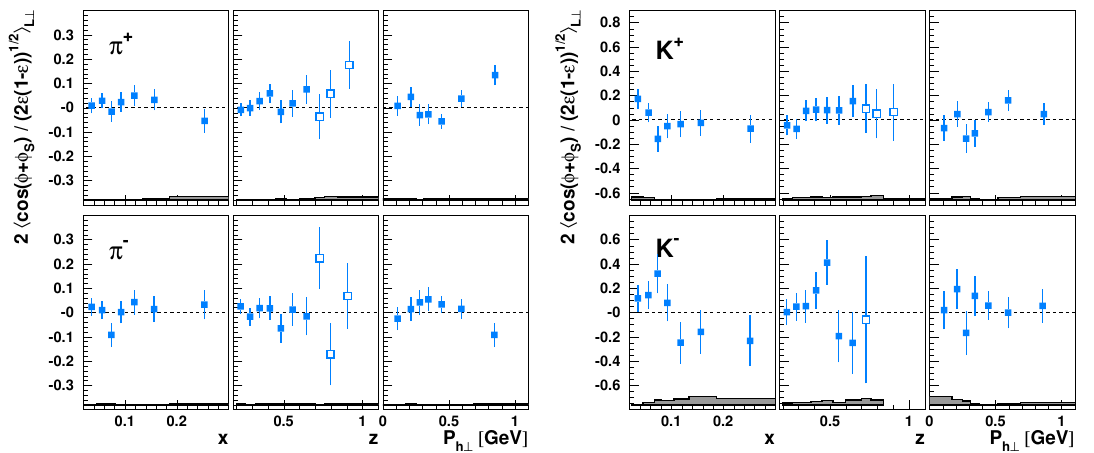
p Figure 35 . The 2 h cos( φ + φ S ) / 2 (cid:15) (1 − (cid:15) ) i h amplitudes for charged mesons (left: pions; right: L ⊥ kaons) presented either in bins of x , z , or P h ⊥ . Data at large values of z , marked by open points in the z projection, are not included in the other projections. Systematic uncertainties are given as bands, not including the additional scale uncertainty of 8.0% due to the precision of the target- polarization determination.